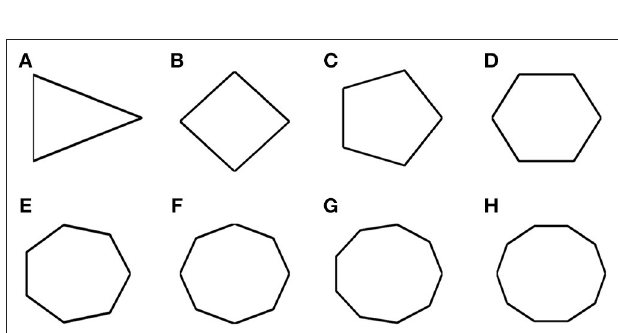
FIGURE 9 | Boundaries of n- sided polygons. (A–H) Environmental shapes used for the analysis of grid cell coding with respect to the number of sides of the polygon; arranged in the order of triangle, square, pentagon, hexagon, heptagon, octagon, nonagon, and decagon (from left to